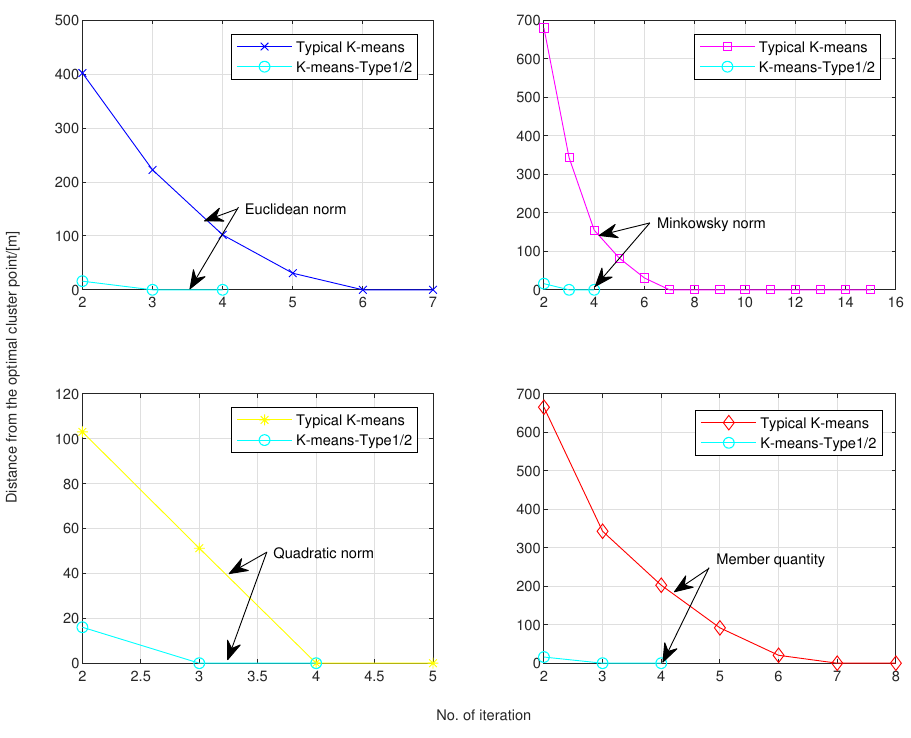
Figure 6. Proposed algorithm convergence speed under different evaluation metrics. In Figure 7, without any relays, vehicles alongside the horizontal road achieved the data packet reception rate at 29.5% while vehicles in the vertical road at 75.1%, and vehicles within 50 meters range to the intersection center could achieve 95% above data packet reception if dividing simulation periods and focusing on packet reception rate variance corresponding to location variance. This is a natural consequence since the line-of-sight (LOS) transmission path dominates the scenario when either the sender or the receiver is at the intersection, while NLOS is typical when both sides are far from the center and not in the same section of road. The square area with 100 m side length is specifically selected as the relay selection area, all vehicles within this area could switch their relay function on, and the maximum relay nodes number is applied to minimize redundancy of relayed transmission. Various methods could be used for relay node candidate confirmation, in the Veins simulation we use our proposed K-means type1 algorithm to initially pick the relay vehicles up, after that the announcement message is used to identify the existence of relay nodes to eliminate potential relay redundancy. It is well noted that the candidate node must listen for a period before switching on relay function. With relay switched on in the simulation, the performance increased to 91.3% for horizontal direction vehicles and 98.9% for vertical direction vehicles, at the cost of 1.99 times more transmission budget for relaying data